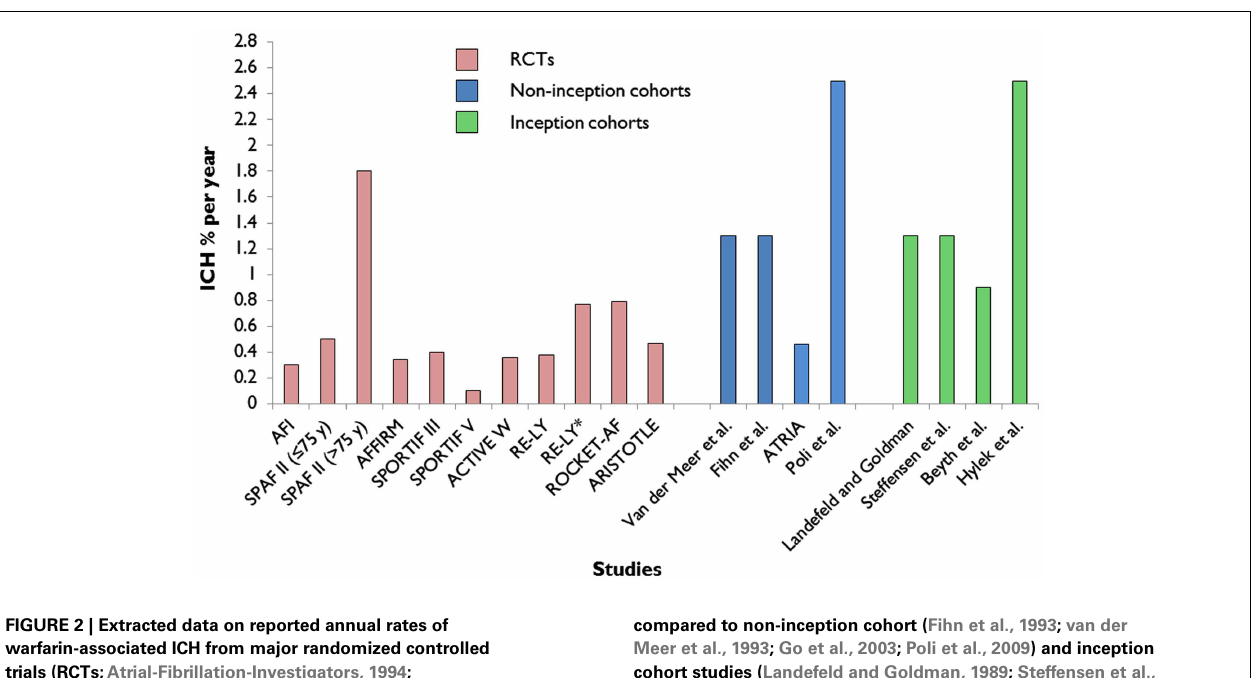
FIGURE 2 | Extracted data on reported annual rates of warfarin-associated ICH from major randomized controlled trials (RCTs;Atrial-Fibrillation-Investigators, 1994; SPAF-Investigators, 1994; Olsson, 2003;Albers et al., 2005; DiMarco et al., 2005; Connolly et al., 2006, 2009; Diener et al., 2010; Granger et al., 2011; Patel et al., 2011) of atrial fibrillation